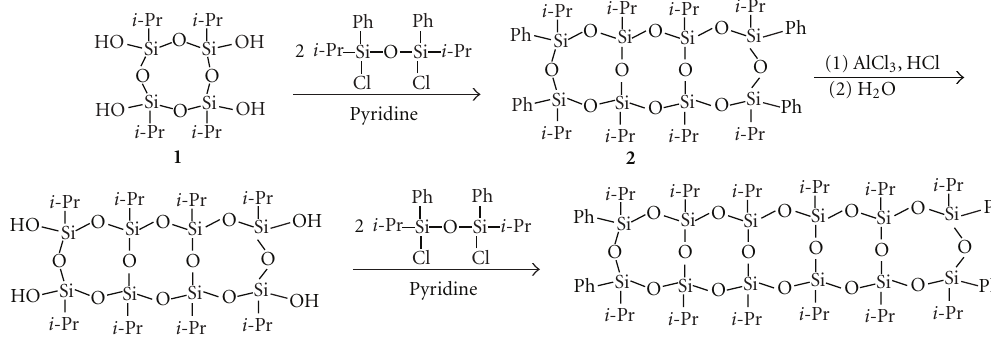
Scheme 1: Synthesis of pentacyclic